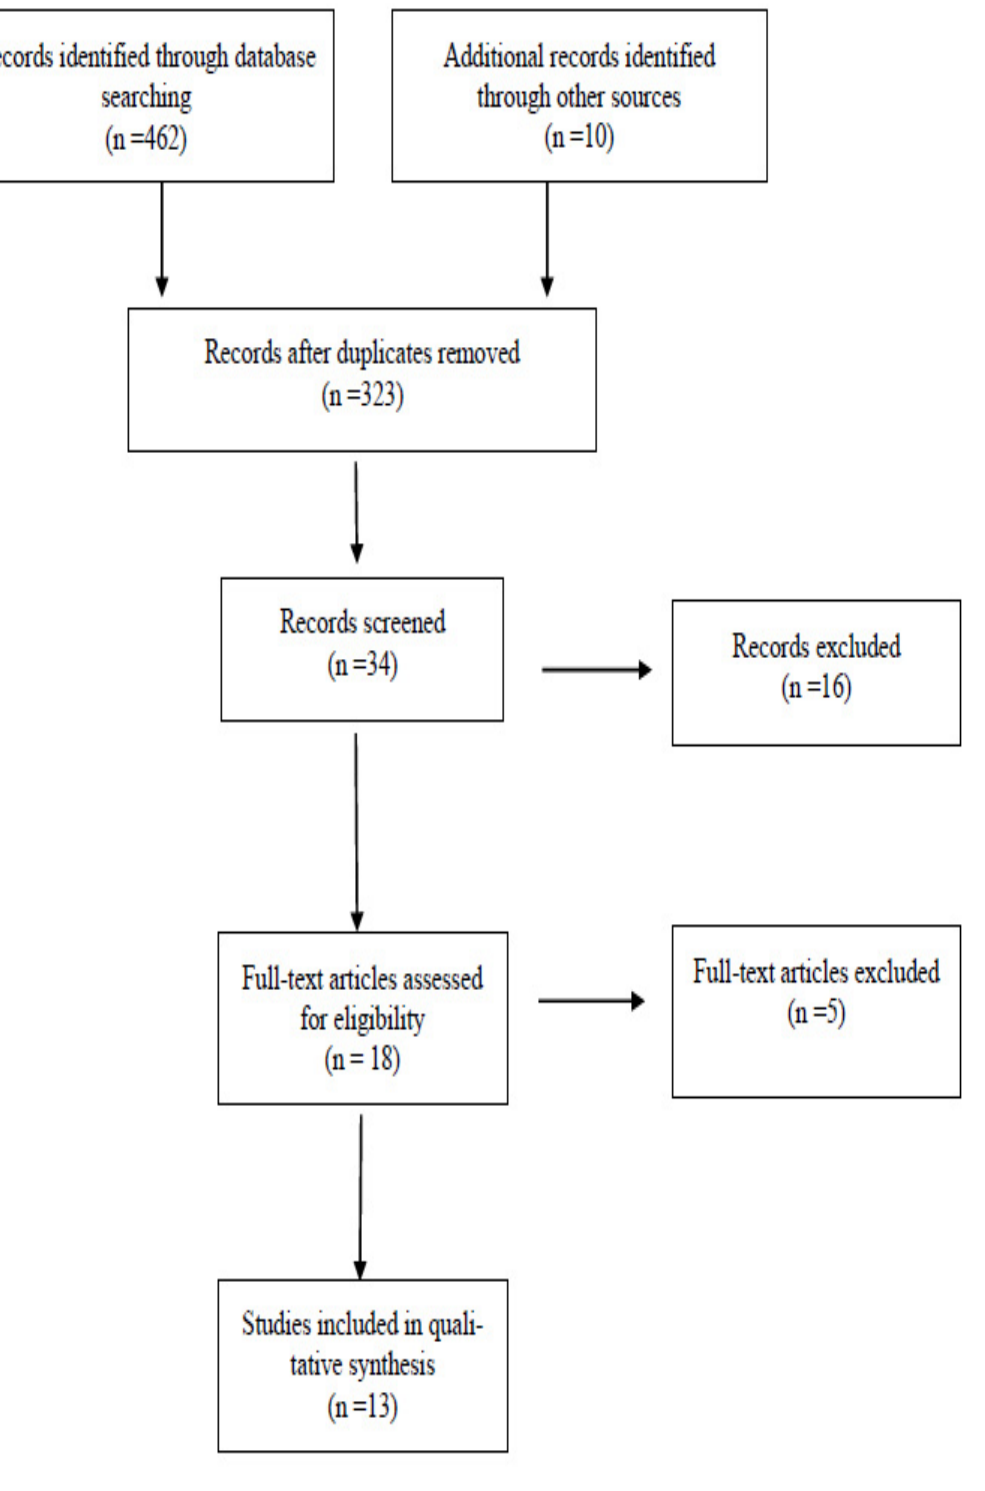
Figure 1. Flow diagram of literature screening process.